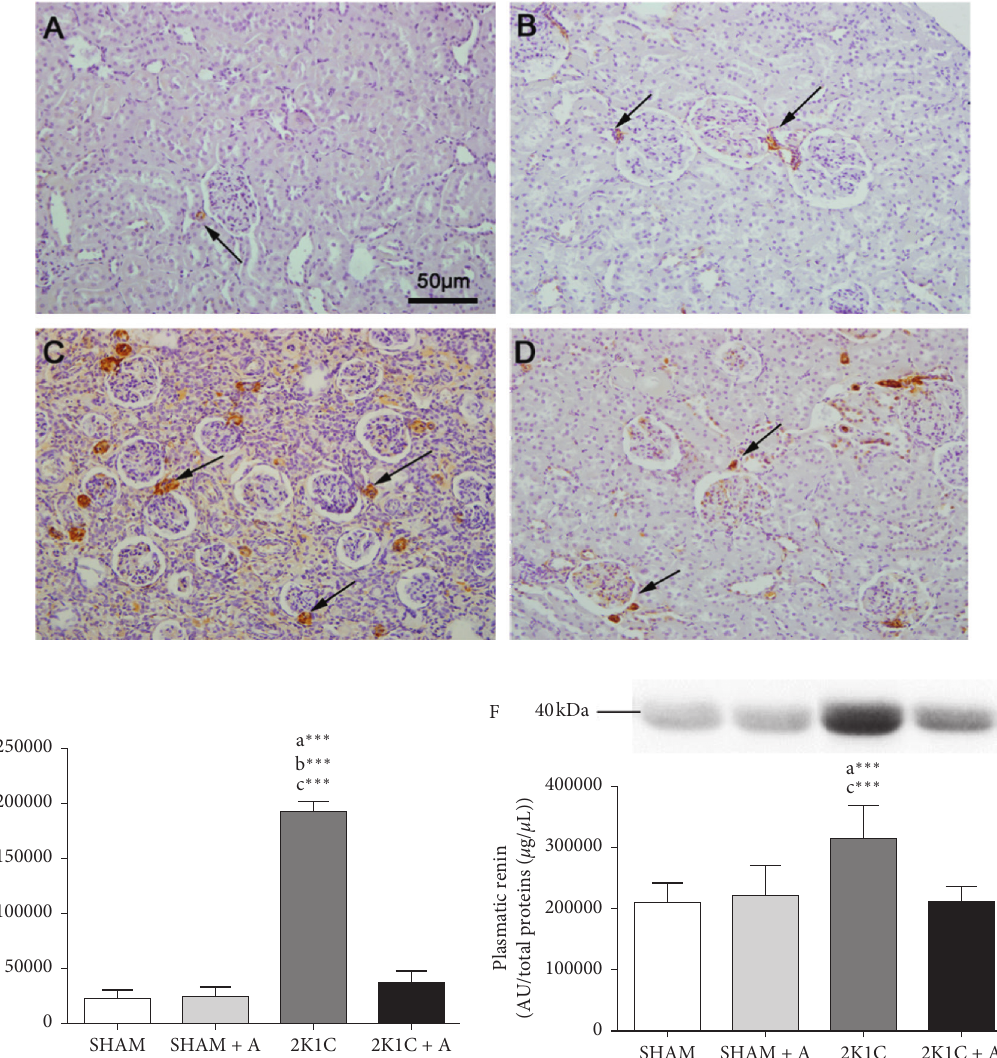
Figure 2: Detection and quantification of renin in renal tissue and plasma. Detection of renin expression by immunohistochemistry in the Sham group (A), Sham+ A (B), 2K1C (C), and 2K1C+ A (D). Arrows indicate positive immunostaining in juxtaglomerular cells. Quantification of renin expression in juxtaglomerular cells of hypertensive and control groups (E). Evaluation of the plasma renin ex- pression in all groups (F). (a) represents ≠ to the SHAM group, (b) represents ≠ to the SHAM +A group, and (c) represents ≠ to the 2K1C +A group. ∗∗∗∗ p < 0 . 0001. n � 10 for all experimental